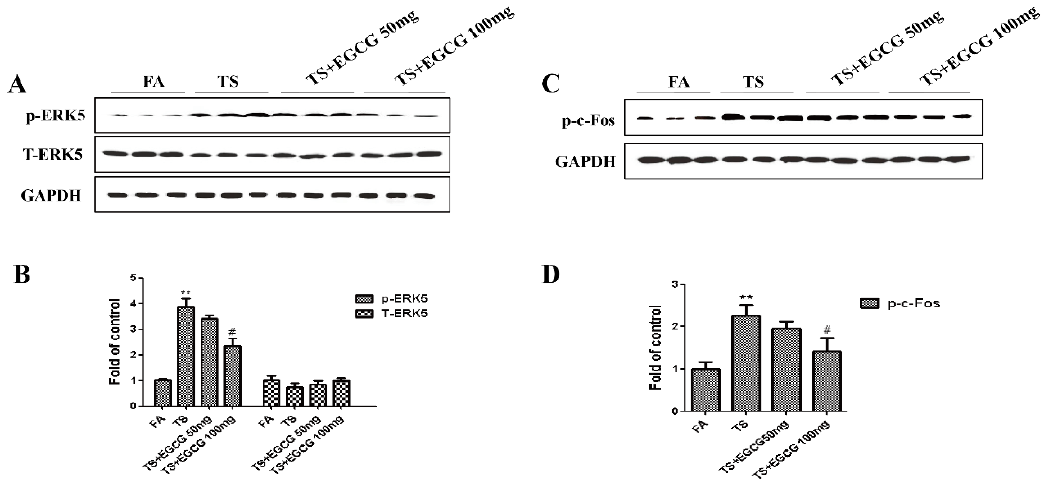
Figure 6. EGCG suppressed tobacco smoke ‐ induced ERK5 activation in mice stomach. ( A ) Western blotting analyses of phosphorylated ERK5 and total ERK5; ( B ) Densitometric analyses of Western blotting; ( C ) Western blotting analyses of phosphorylated c ‐ Fos; ( D ) Densitometric analyses of Western blotting. Data are expressed as mean ± SD. ** p < 0.01, compared with FA control; # p < 0.05, compared with TS. FA = filtered air; TS = tobacco smoke.